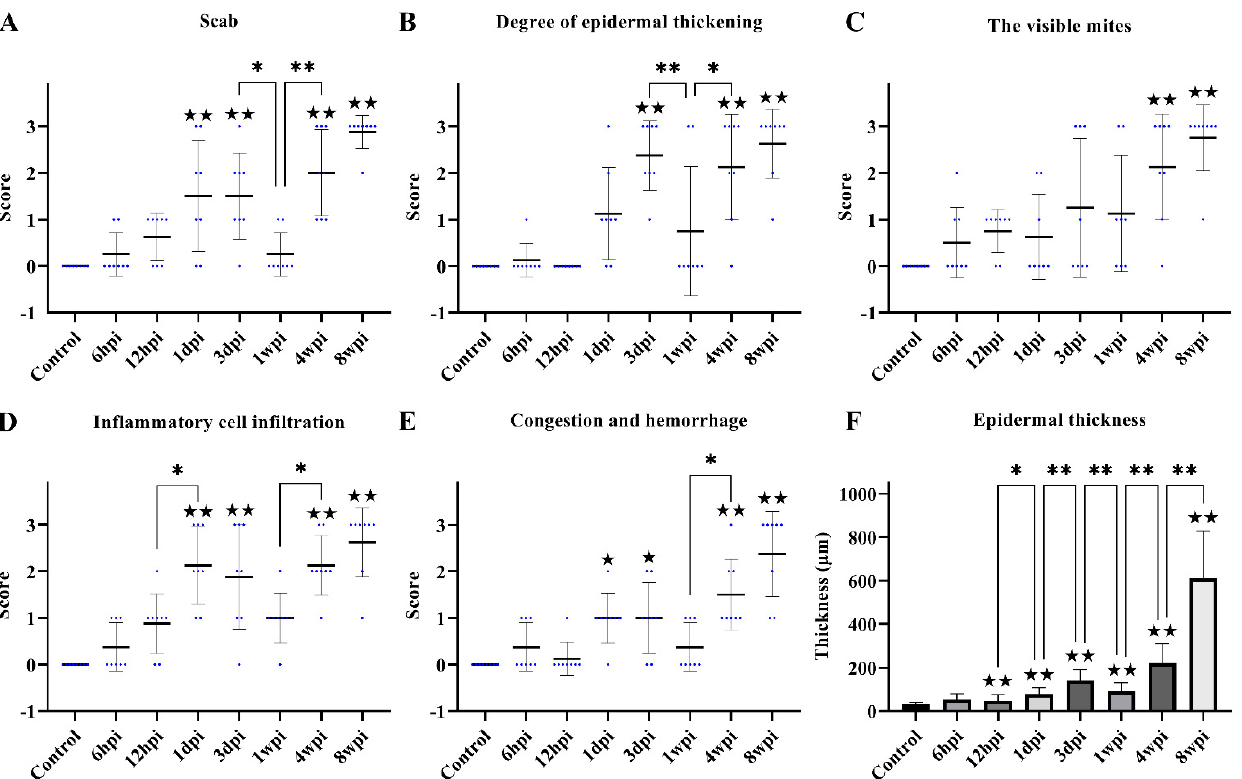
Figure 3. Scoring of pathological changes. ( A ) Scab, ( B ) degree of epidermal thickening, ( C ) the visible mites, ( D ) inflammatory cell infiltration, ( E ) congestion and hemorrhage, and ( F ) epidermal thickness. ( A – E ) shows the score of skin pathological changes according to the Table 1, blue dots represent the number of rabbits, and the black line represent the average score. ( F ) shows epidermal thickness measured by Image-Pro Plus 5.1 software, randomly measuring at least 30 widths of each H&E-stained skin section along the epidermis. Data were represented as the mean ± standard deviation. (M ± SD). The horizontal line indicates a significant adjacent pairwise group difference (* p < 0.05 and ** p < 0.01). ★ on the bar represents a significant difference between the specific experimental group and the control group ( ★ p < 0.05 and ★★ p < 0.01). Table 1. Pathological damage scoring criteria for rabbit skin.